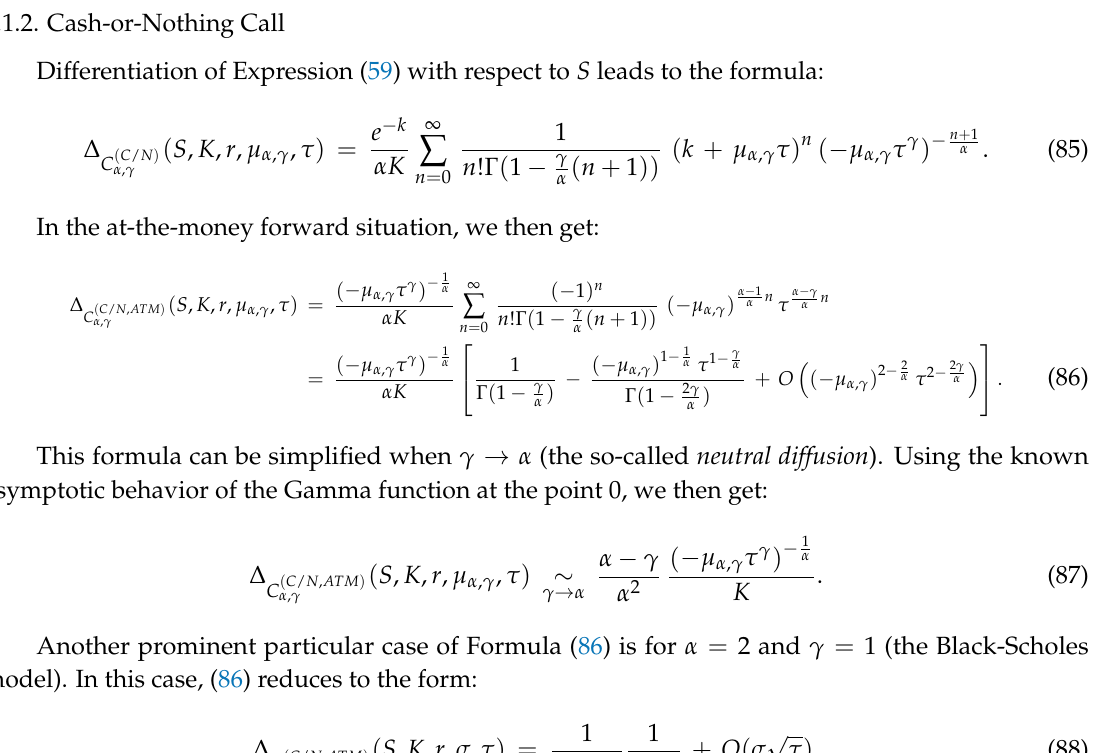
Figure 1. In the left figure, we plot the evolution of the Delta of an European call option as a function of S for various values of γ . We observe that, as expected from (83), the At-The-Money (ATM) call price is approximately equal to 1 for any γ , and moreover, the Delta value is the same on a wide range of prices α around S 0 , independently of γ . The situation is very different on the right figure (plot of the Gamma of the European call option (93)), where sensitivities vary greatly in dependence of γ . To produce the figures, the following values of parameters were used: K = 4000, r = 1%, σ = 20%, τ = 1 Y , α =